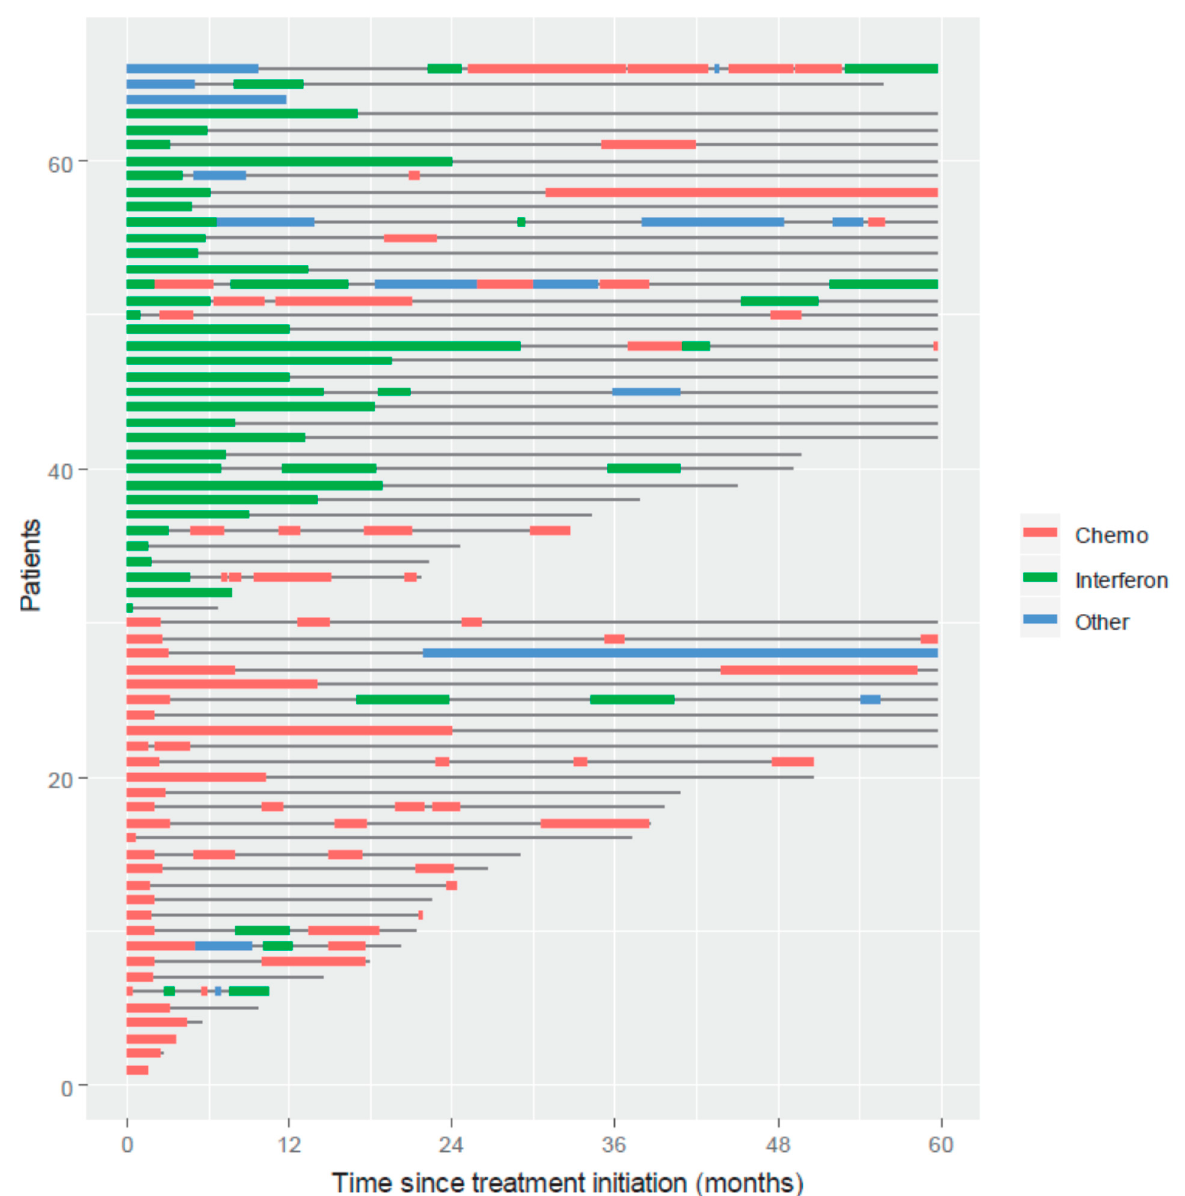
Figure A1. Lollipop plot representing treatment course of the 66 classic/endemic KS patients who received systemic treatment. Each line represents a single patient. Treatment course is represented during the first five years of follow-up. Treatment free periods are represented by a grey line while treatment intervals correspond to green, red or blue boxes when patients are treated with interferon, chemotherapy or other regimens respectively.